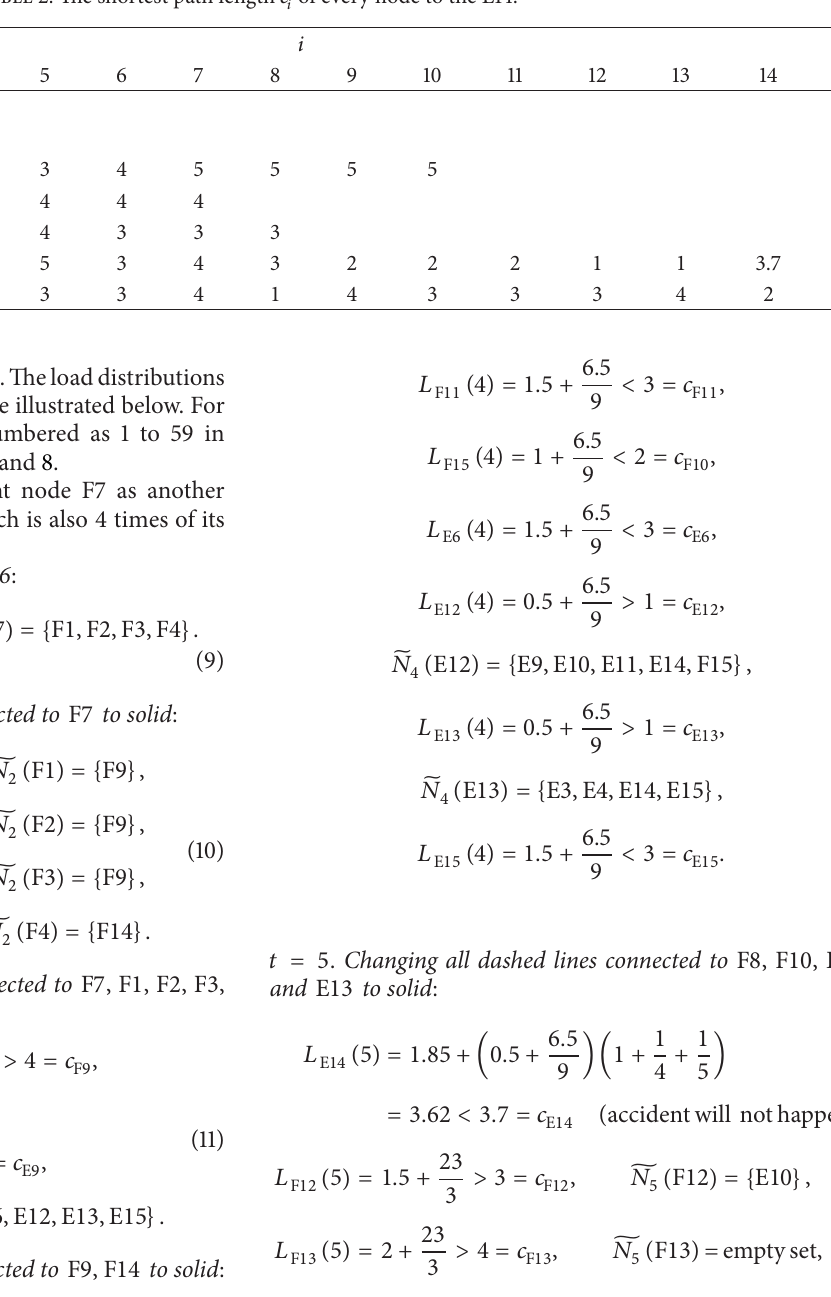
Table 2: The shortest path length 𝑐 𝑖 of every node to the